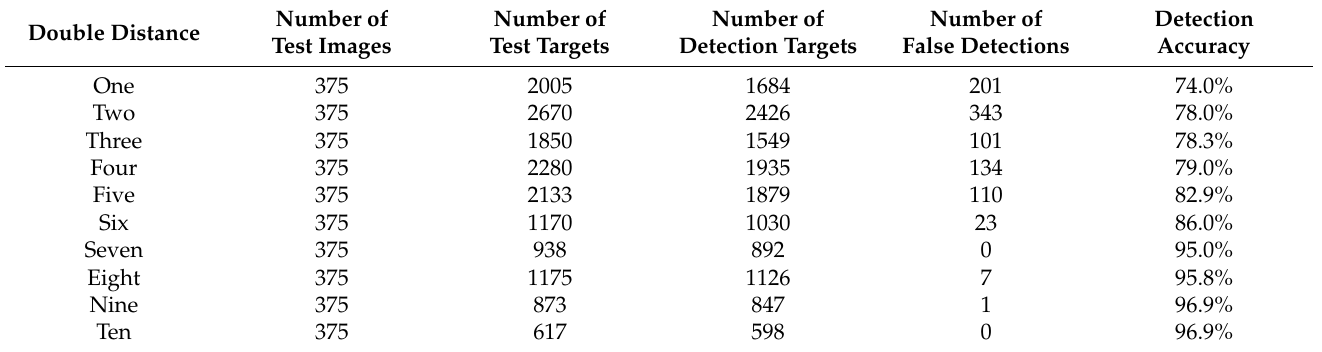
Table 6. Statistics of test results at different magnifications.